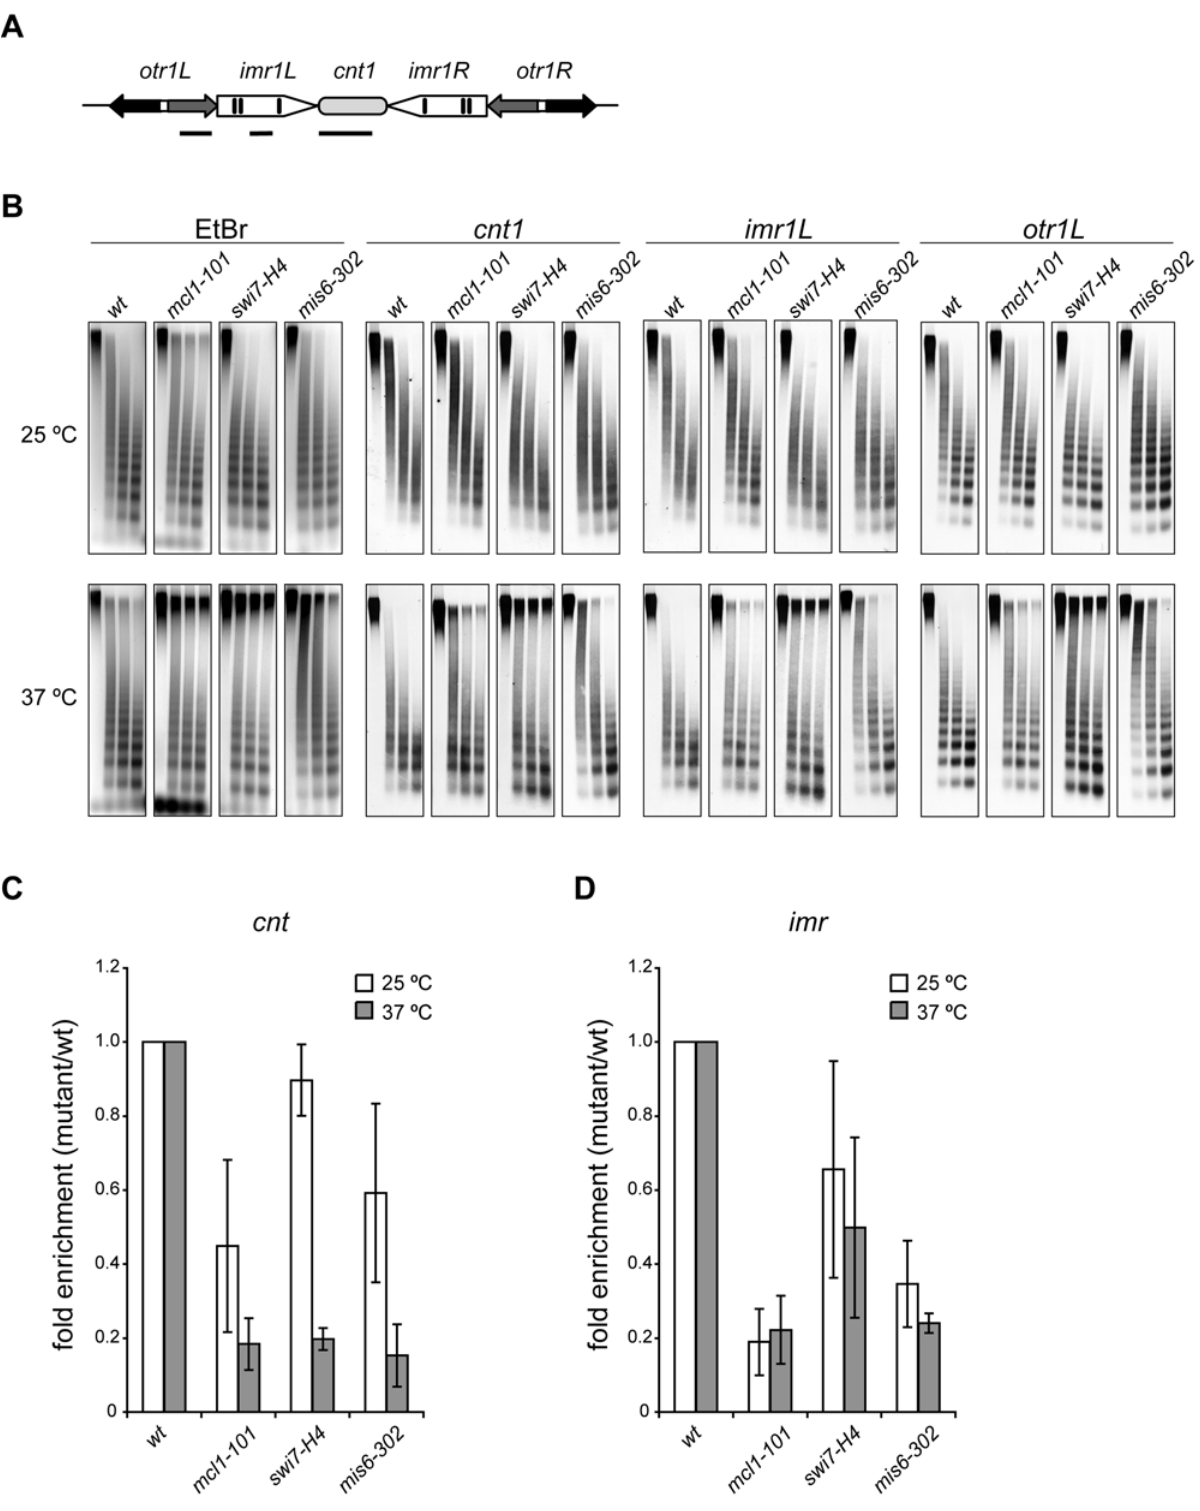
Figure 4. The specialized chromatin structure and association of Cnp1 at central core region is impaired in mcl1-101 and swi7-H4 mutants. ( A ) Locations of probes used in Southern hybridization are depicted as horizontal lines. ( B ) The cells were harvested from cultures incubated at 25 u C or 37 u C for 6 hrs and permeabilized by enzyme treatment and chromatin was partially digested with MNase. DNA was extracted, separated on agarose gel, and subjected to Southern hybridization using probes shown in (A). Smeared digestion patterns characteristic of central core region ( cnt1 and imr1L ) were partially replaced with ladder patterns in mcl1-101 and swi7-H4 mutants. Strains were wild-type (JY746), mcl1-101 (NYSPC41), swi7-H4 (TN310) and mis6-302 (NYSPL59). ( C ) ChIP was performed using the antiserum raised to Cnp1. The cells were incubated at 25 u C or 37 u C for 6 hrs and then fixed. The ratio of ChIPed DNA to input DNA was calculated as described in Materials and methods and average fold